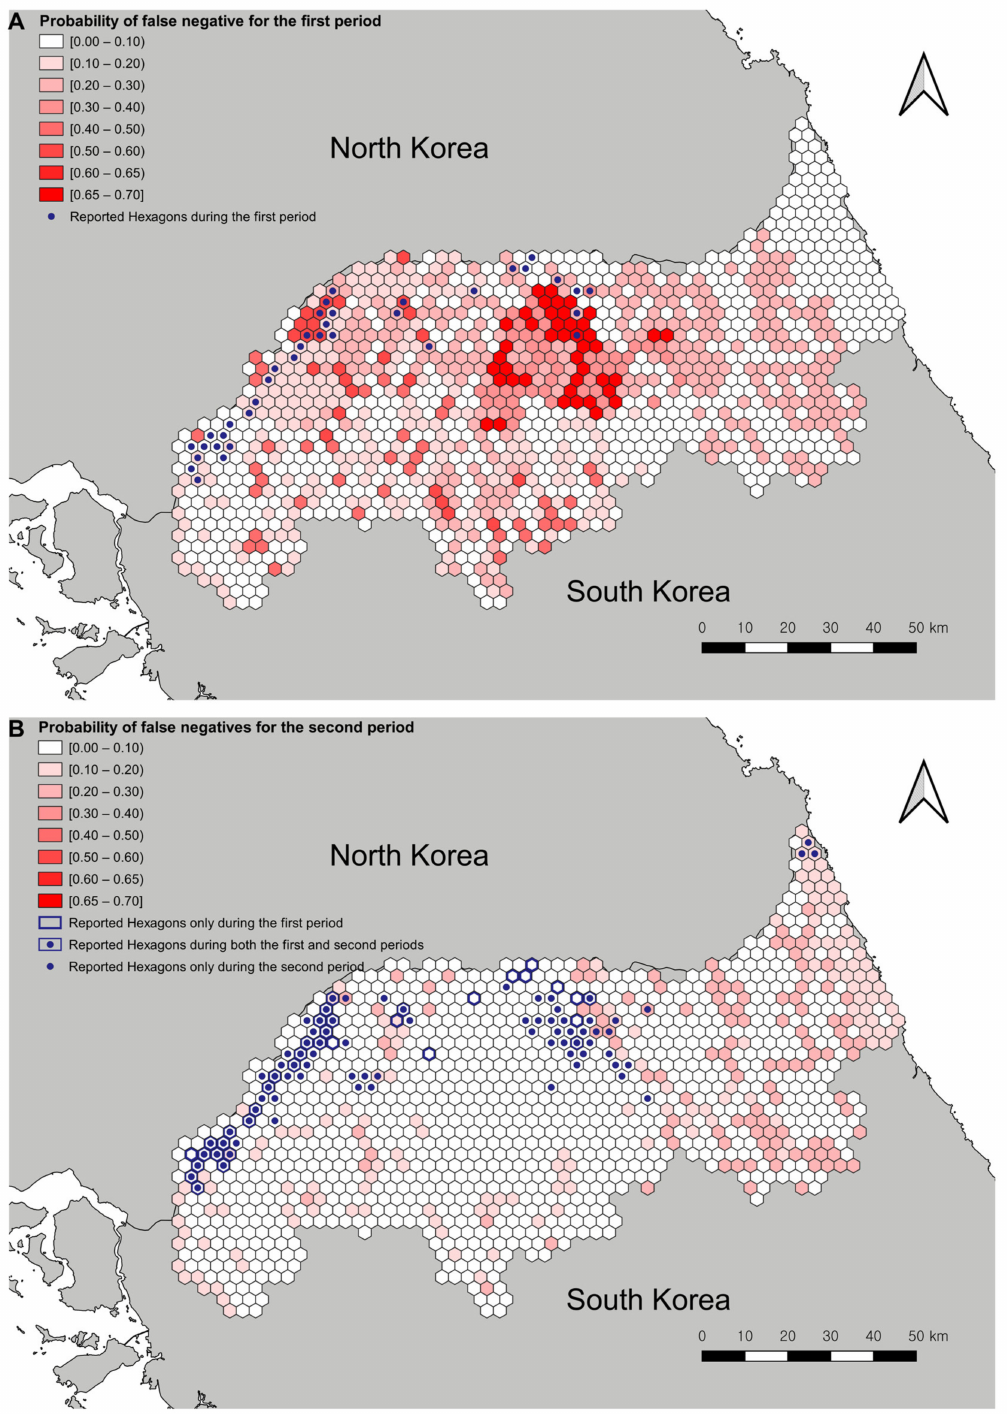
Figure 4. Choropleth map of the probability of false negative during the first ( A ) and second period ( B ). These maps were plotted using QGIS version 3.4.11. http://qgis.osgeo.org (accessed on 10 March